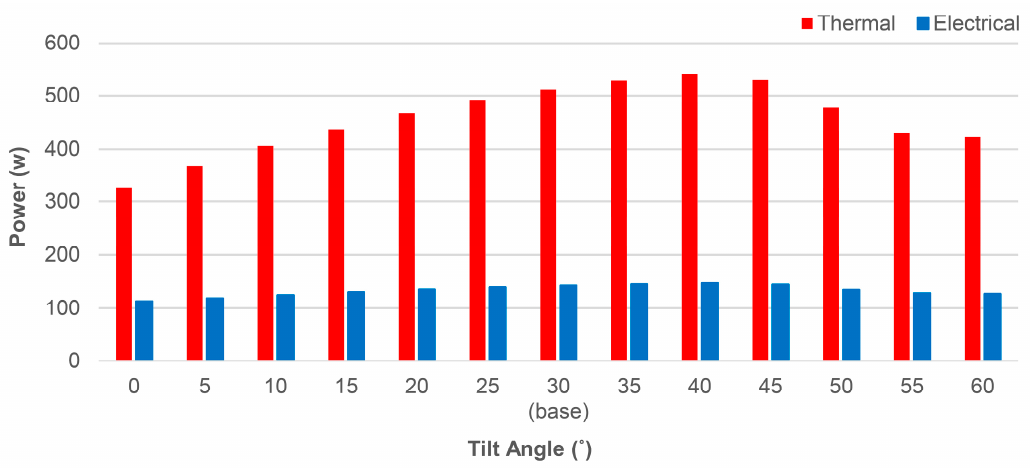
Figure 20. Thermal and electrical power of the collector for di ff erent tilt angles.